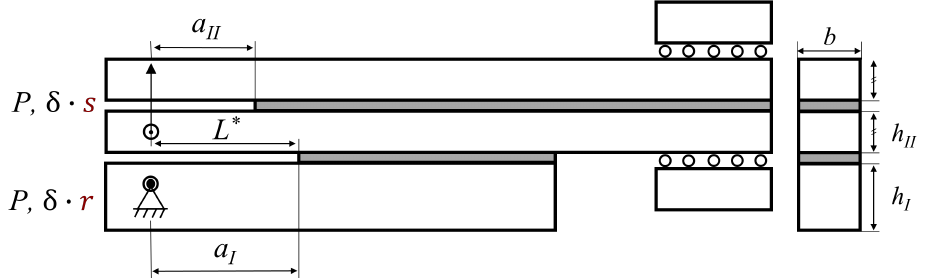
Figure A1. Schematic representation of the mDCB’s mechanical and dimensional parameters needed to deduce the compliance-based beam method (CBBM) data reduction scheme. In terms of variables, P and δ are the applied load and respective displacement, where r and s define the percentage of displacement supported by each part of the specimen, the lower beam (mDCB— r ) and the upper composed beam (ELS— s